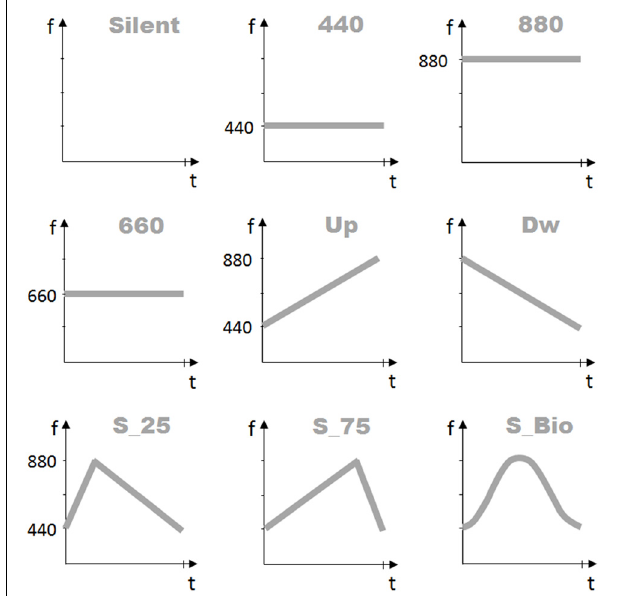
FIGURE 2 | Sound frequency profiles. The nine graphs represent the frequency profiles of the auditory stimuli proposed to the participants in the three Experiments. The first line presents the three auditory conditions proposed in Experiment 1: “Silent” (no-sound), “440” (constant sound frequency, at 440 Hz), and “880” (constant sound frequency, at 880 Hz). The second line presents the three auditory conditions proposed in Experiment 2: “660” (constant sound frequency, at 660 Hz), “UP” (linearly increasing frequency between 440 Hz and 880 Hz), and “DW” (linearly decreasing frequency between 880 and 440 Hz). Finally, the third line presents the three auditory conditions proposed in Experiment 3: “S_Tri_25” (triangular profile, between 440 and 880 Hz, peak at 25% of the total duration), “S_Tri_75” (triangular profile, between 440 Hz and 880 Hz, peak at 75% of the total duration), and “S_BIO” (reproducing the bell shape of the “BIOlogical” velocity profile). X -axis represents the time duration of the stimulus, in seconds; Y -axis presents the sound frequency values in